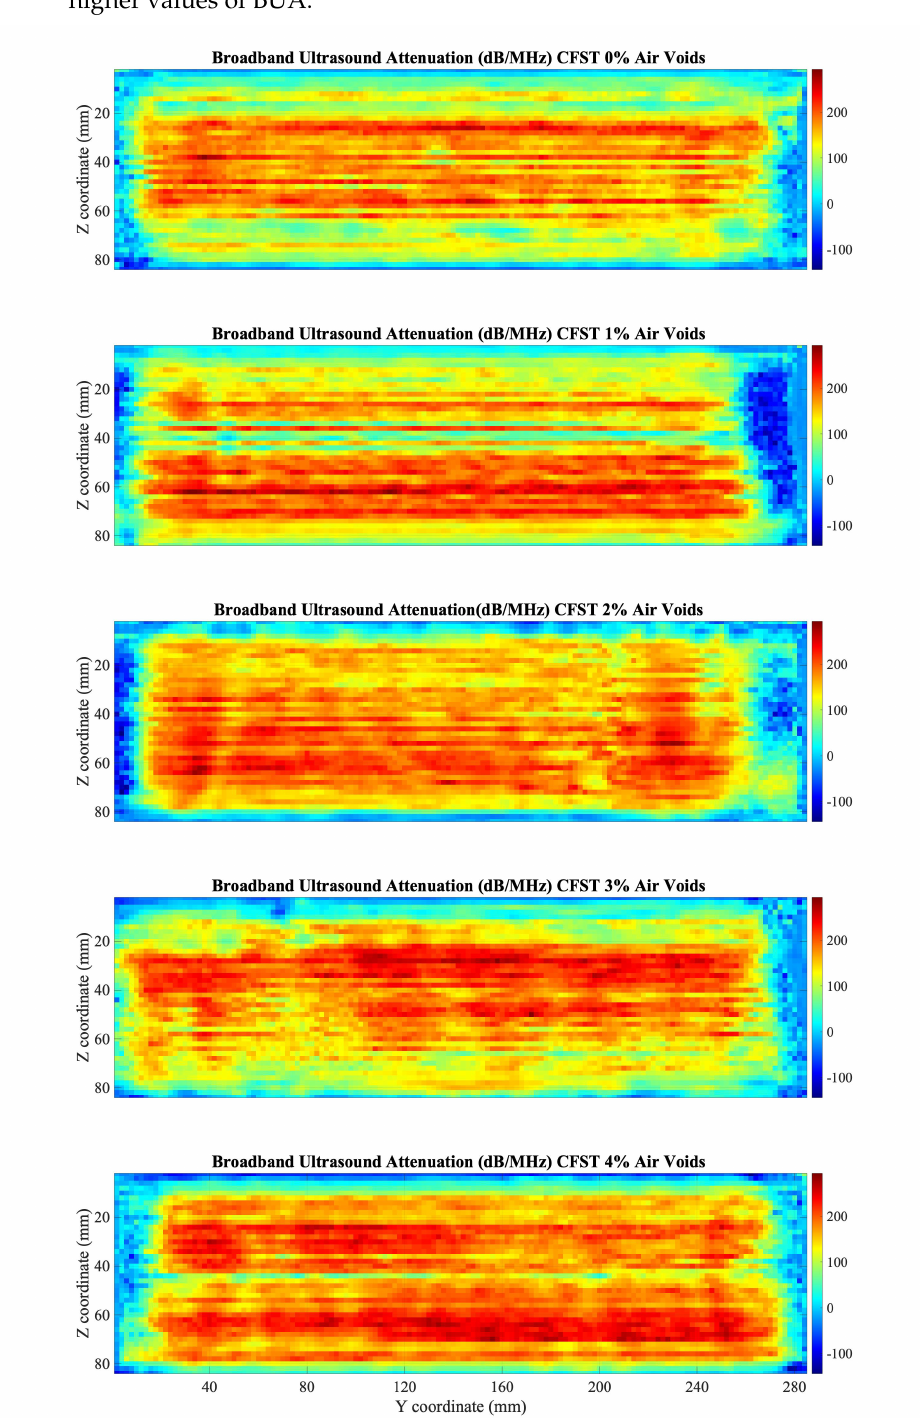
Figure 11. C-Scan of BUA values in dB/MHz for the five CFST